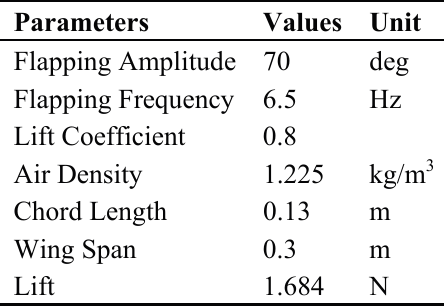
Table 5. Approximated lift